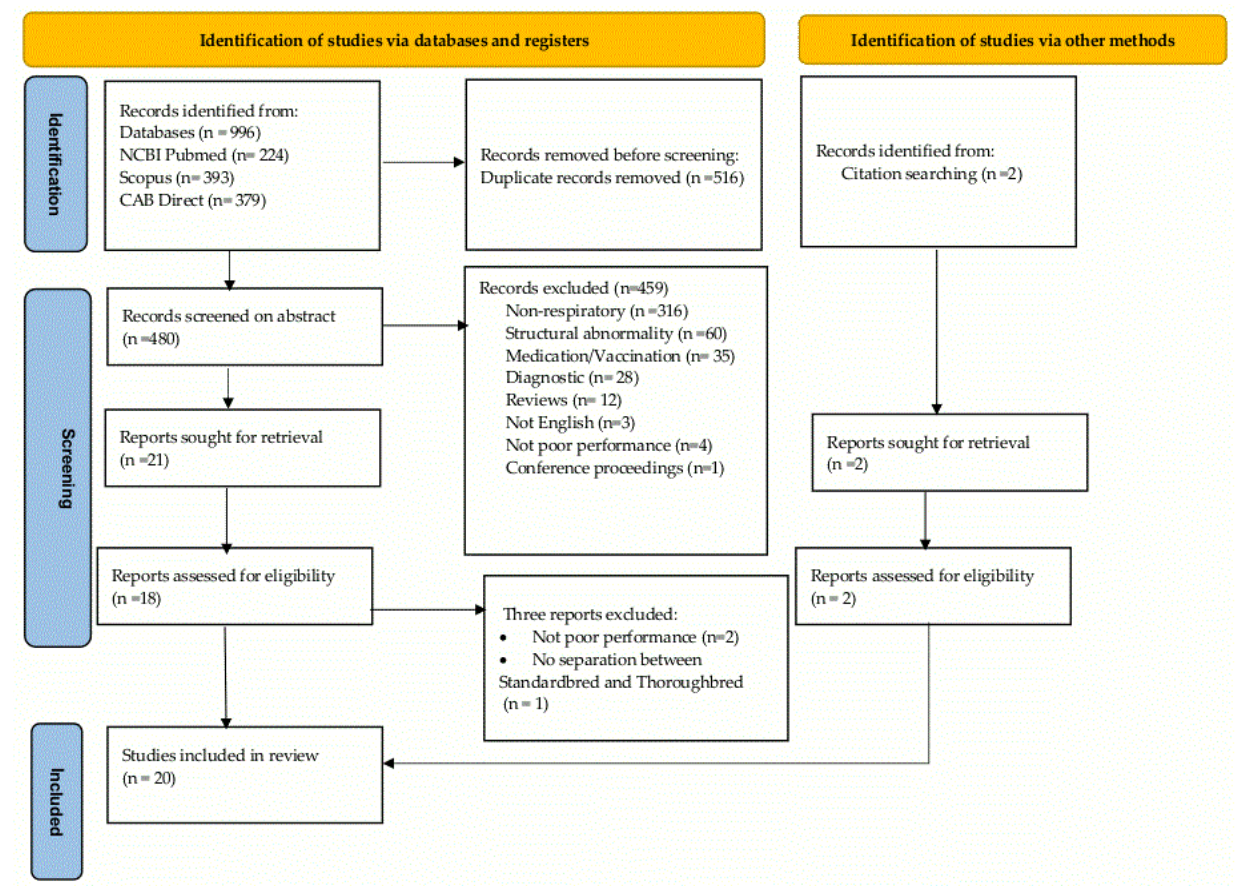
Figure 1. Search and selection flowchart for scoping review of non-structural airway disease as a cause of poor performance in racehorses [17] .